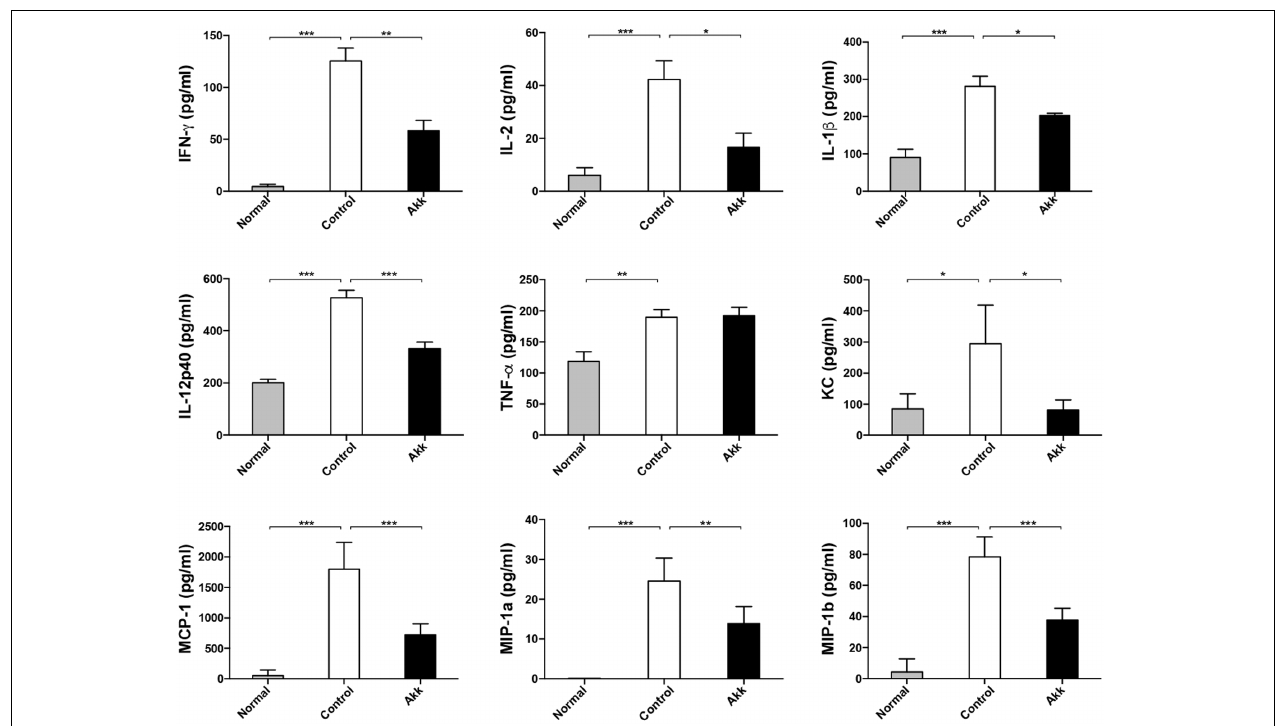
FIGURE 2 | Pretreatment with A. muciniphila relieved Con A-induced cytokine expression in the serum. The increased production of IFN- γ , IL-2, IL-1 β , and IL-12p40 was significantly diminished, along with reduced chemokines, including KC, MCP-1, MIP-1a, and MIP-1b. However, TNF- α concentration was not evidently reduced. Data are shown as the mean ± SEM. N = 5–8 per group. ∗ P < 0.05, ∗∗ P < 0.01, ∗∗∗ P < 0.001 by post hoc ANOVA one-way statistical analysis or Kruskal–Wallis